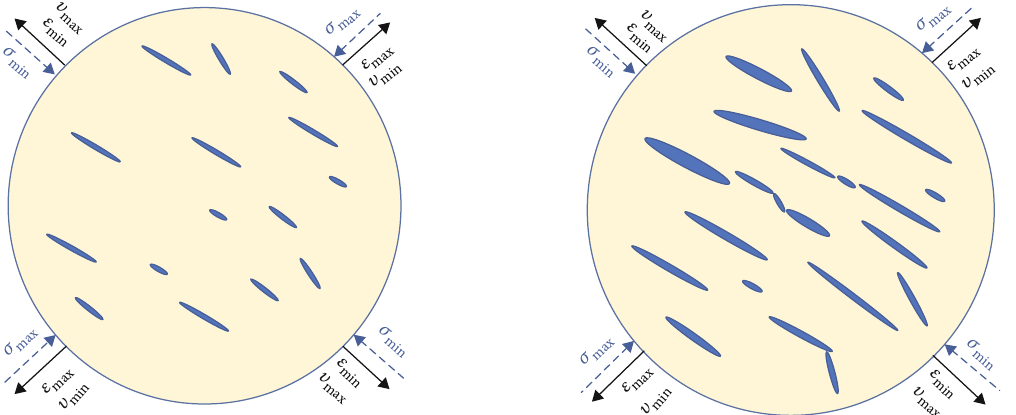
Figure 13: Schematic diagram of unloading cracks generated by the release of ground